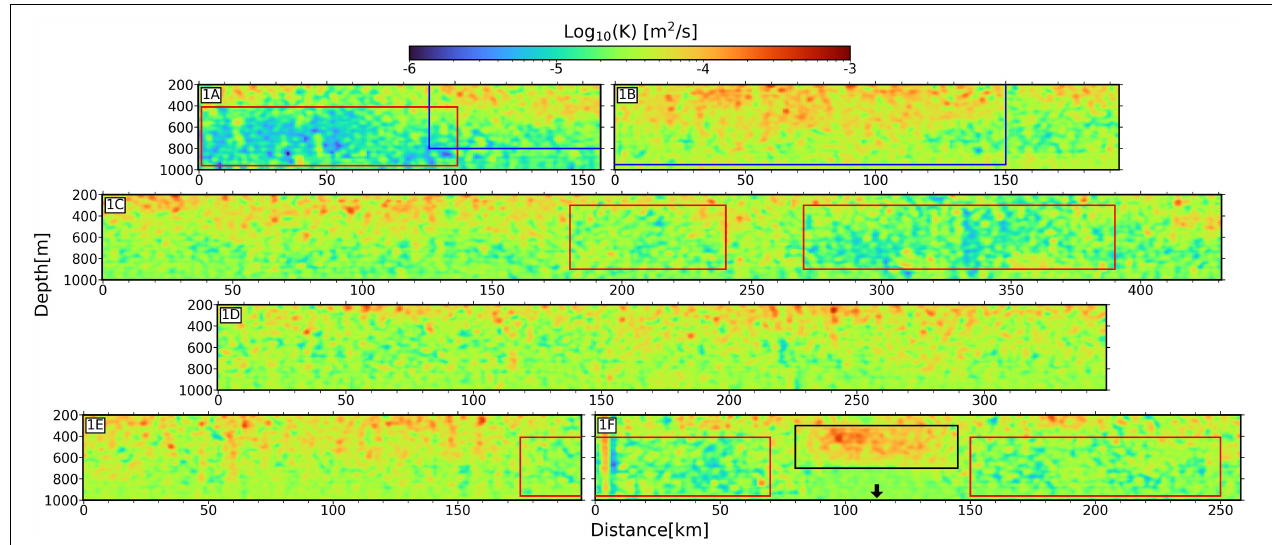
FIGURE 5 | Turbulent diffusivity maps derived from seismic sections in Figure 4 . Red boxes = locations of lower diffusivities; blue boxes = an example location of enhanced mixing; black box = enhanced mixing above the MAR. Black arrow points at the location of the crest of the MAR. Colored boxes are the same as in Figure 4